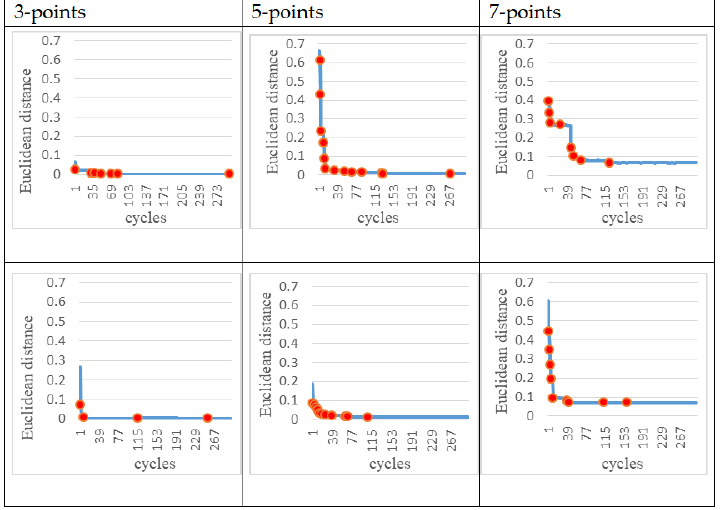
Figure 14. Learning progress of the ANM system for the target points taken from the target trajec-